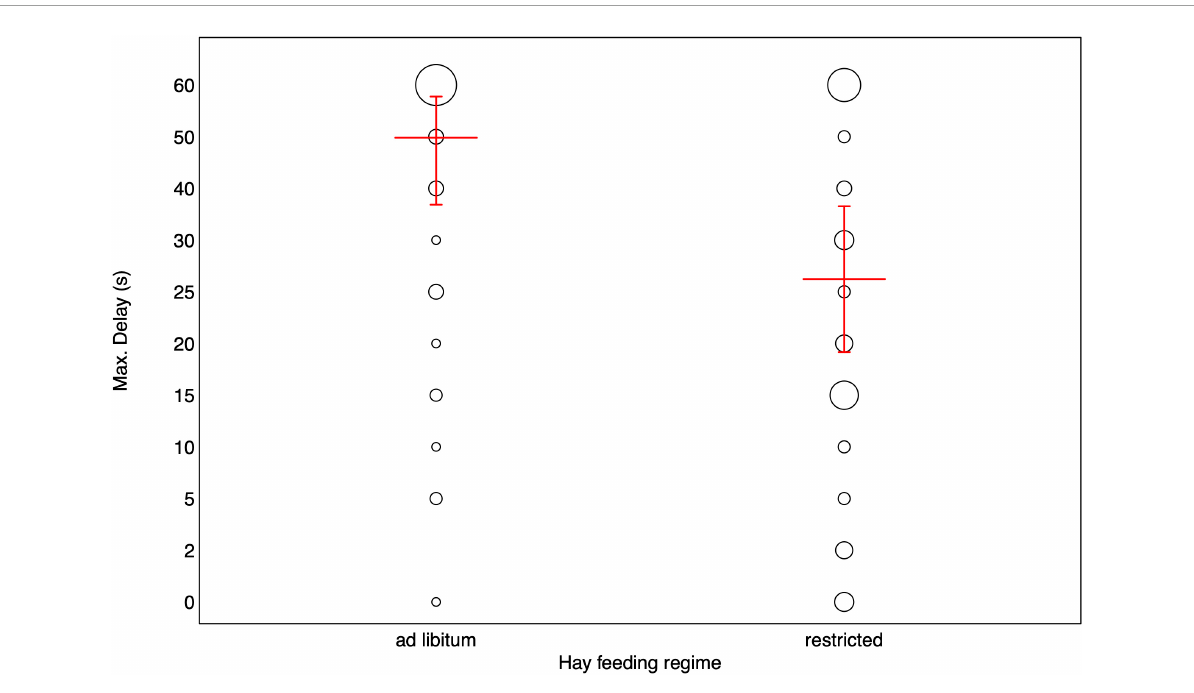
FIGURE2 Maximum delay stages reached by horses fed hay ad libitum and restricted. Bubbles depict the frequency of maximally tolerated delay stages while the size of the bubbles corresponds to the number of horses [range: 1 (smallest bubble) – 23(largest bubble)]. The red horizontal bar depicts the fitted model and the error bars show the confidence limits for all other variables in the model centered to a mean of zero.